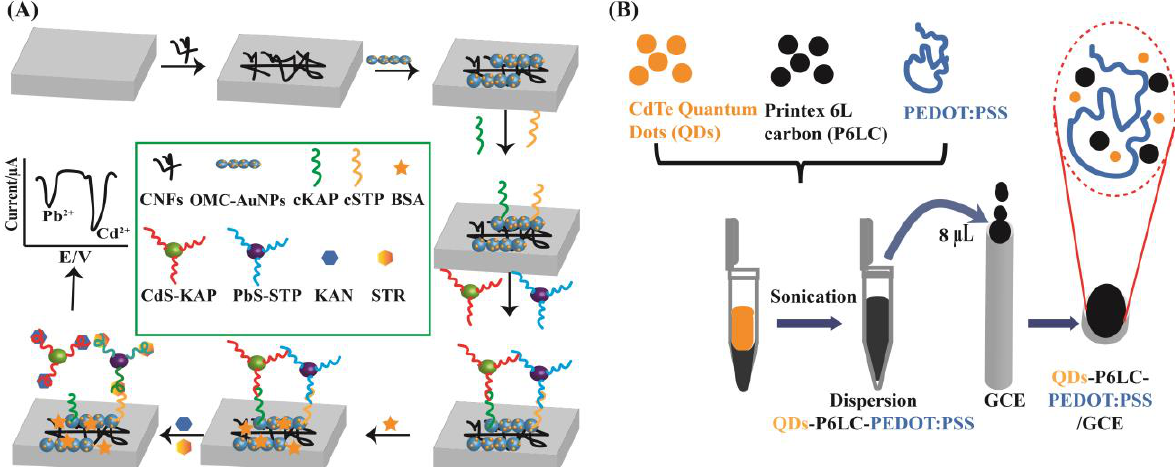
Figure 5. Nanomaterial-based electrochemical methods for antibiotic analysis. ( A ) The ultrasensitive electrochemical detection of kanamycin and streptomycin carbon nanofibers and mesoporous carbon- gold nanoparticles [40]. ( B ) An electrochemical device for the determination of amoxicillin based on a combination of nanomaterials such as Printex 6 L Carbon and cadmium telluride quantum dots within a poly(3,4-ethylenedioxythiophene) polystyrene sulfonate film